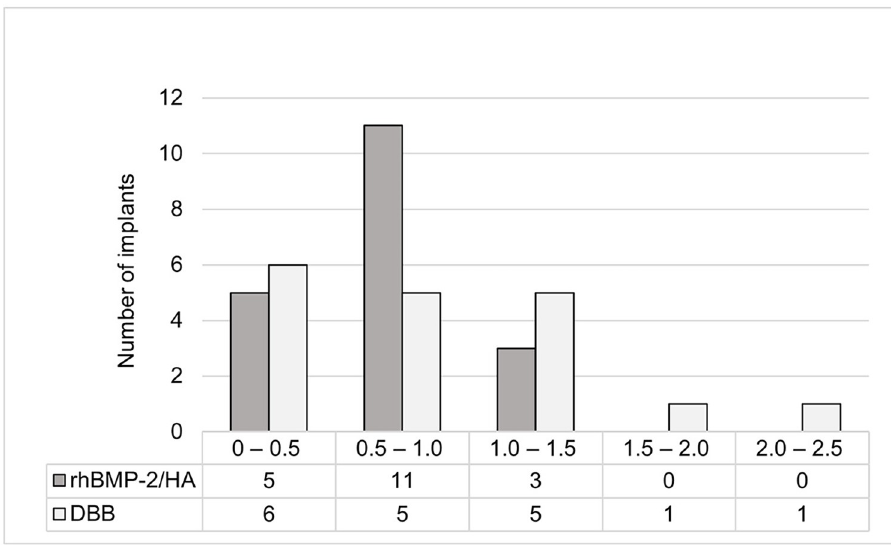
Fig 1. Distribution of marginal bone loss for the rhBMP-2/HA and DBB groups. rhBMP-2, recombinant human bone morphogenetic protein 2; HA, hydroxyapatite; DBB, deproteinized bovine